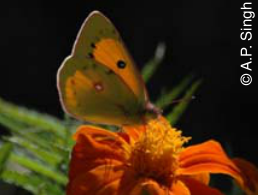
118. Dark Clouded Yellow, Colias fieldi